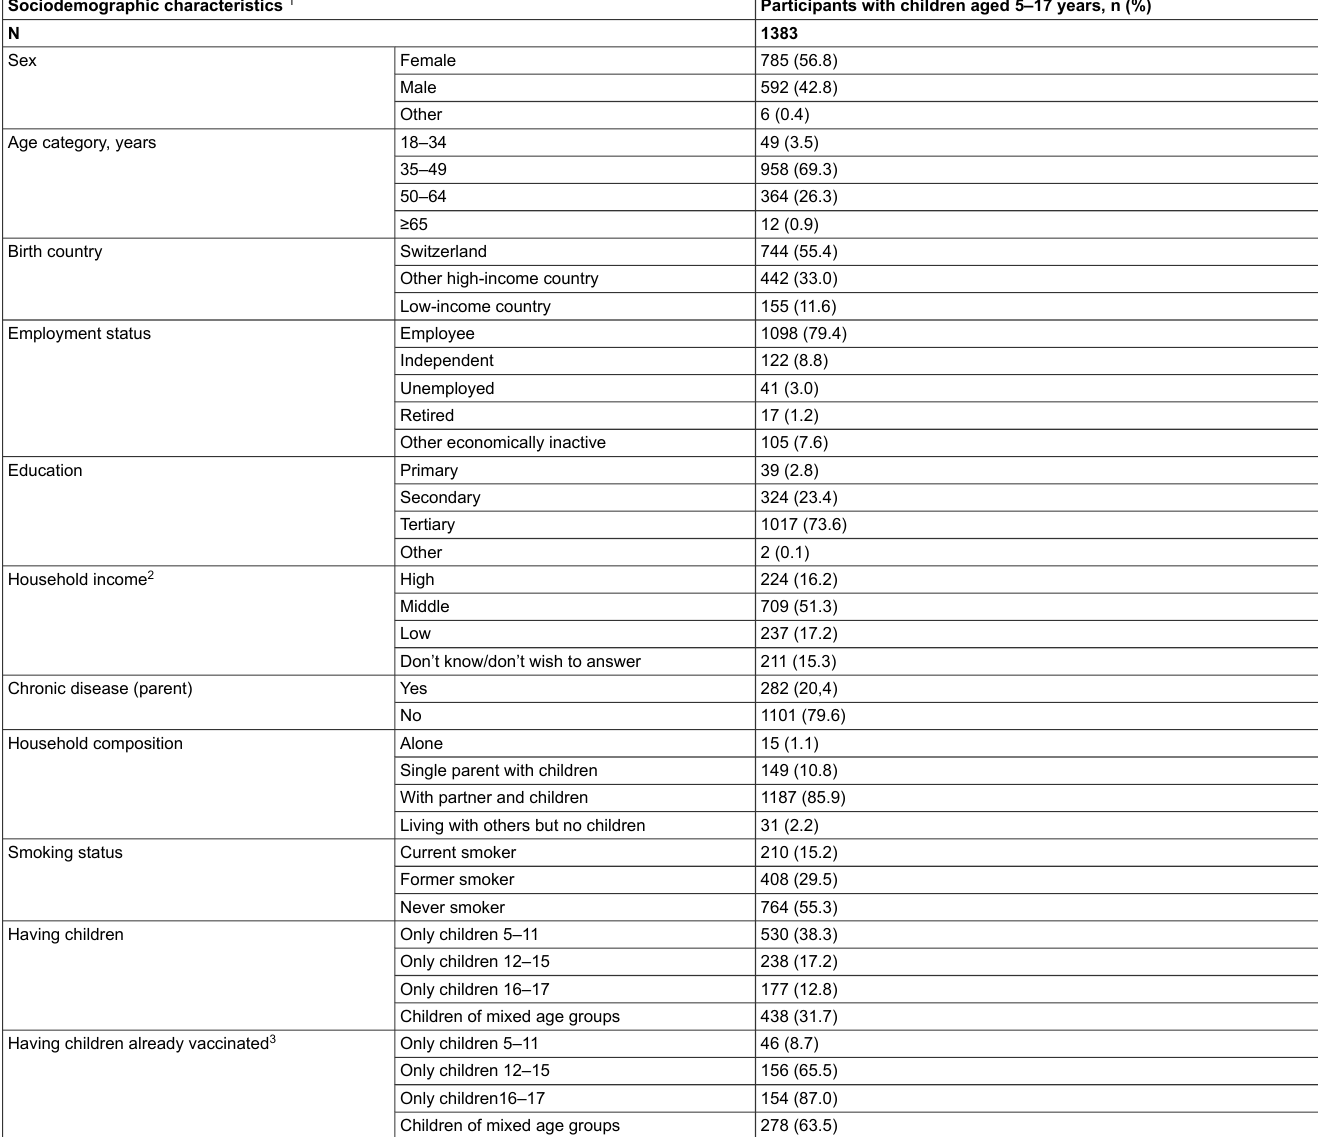
Table 1: Sociodemographic and health-related characteristics of the study participants. Sociodemographic characteristics